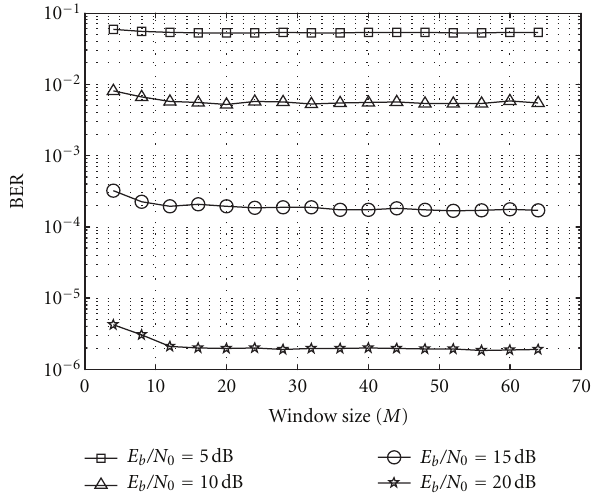
Figure 11: BER performance partial PIC-MRC under di ff erent window size M in SCBT system.